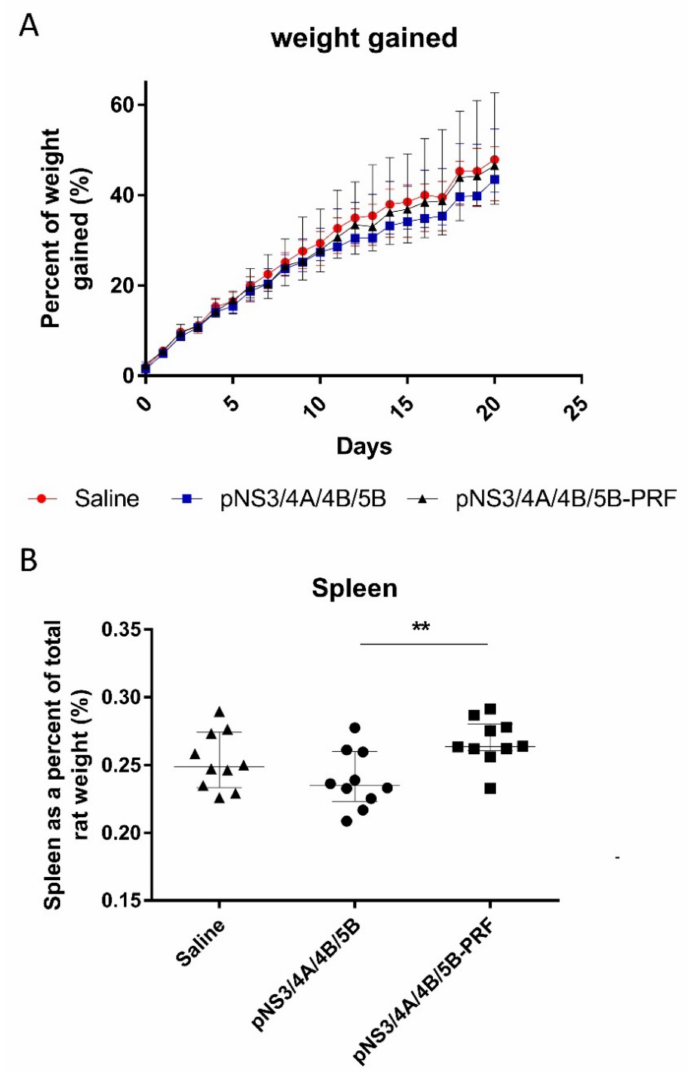
Figure 4. Weight of Sprague Dawley rats after vaccination. Rats were injected with 150 µ g of DNA on Day 0 followed by 450 µ g DNA on Days 5 and 15, then killed and necropsies performed on Day 23. Weight of ( A ) rat was measured daily and increase graphed as a percentage and ( B ) spleen as a percentage of total rat weight. Data shown as median ( n = 10) and interquartile range. ** p ≤ 0.01 (Mann–Whitney